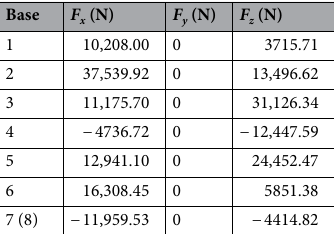
Table 2. The force table of each fulcrum of the box body in reverse gear.